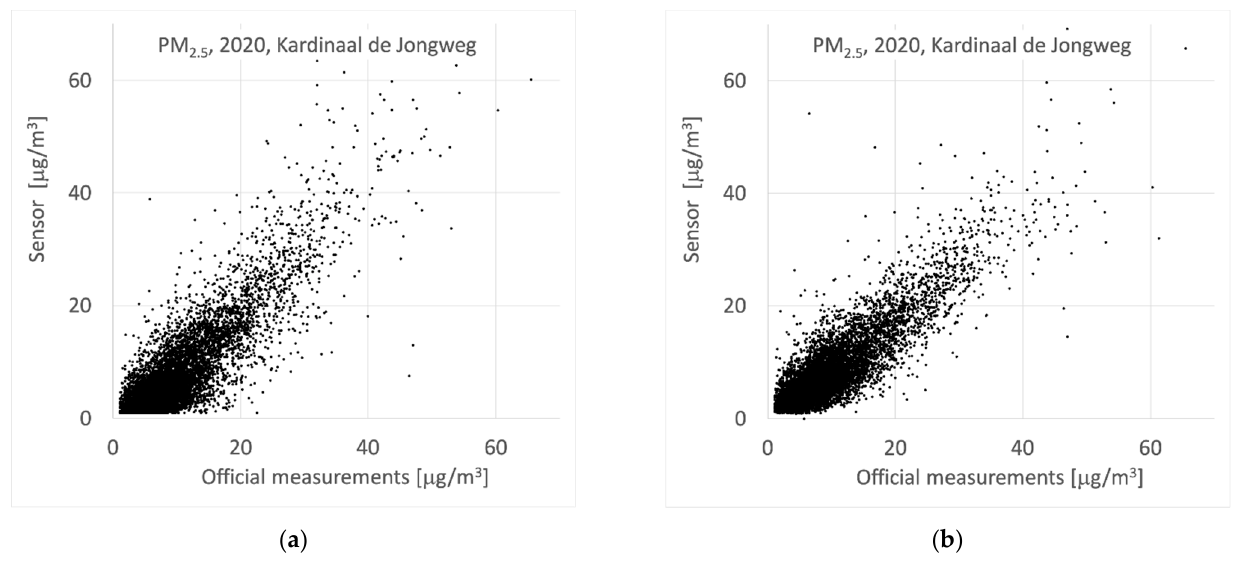
Figure 6. ( a ) Results of official measurements and co-located/nearby raw (uncalibrated) sensors at the location “Kardinaal de Jongweg”; ( b ) results of official measurements and co-located/nearby calibrated sensors at the location “Kardinaal de Jongweg”.